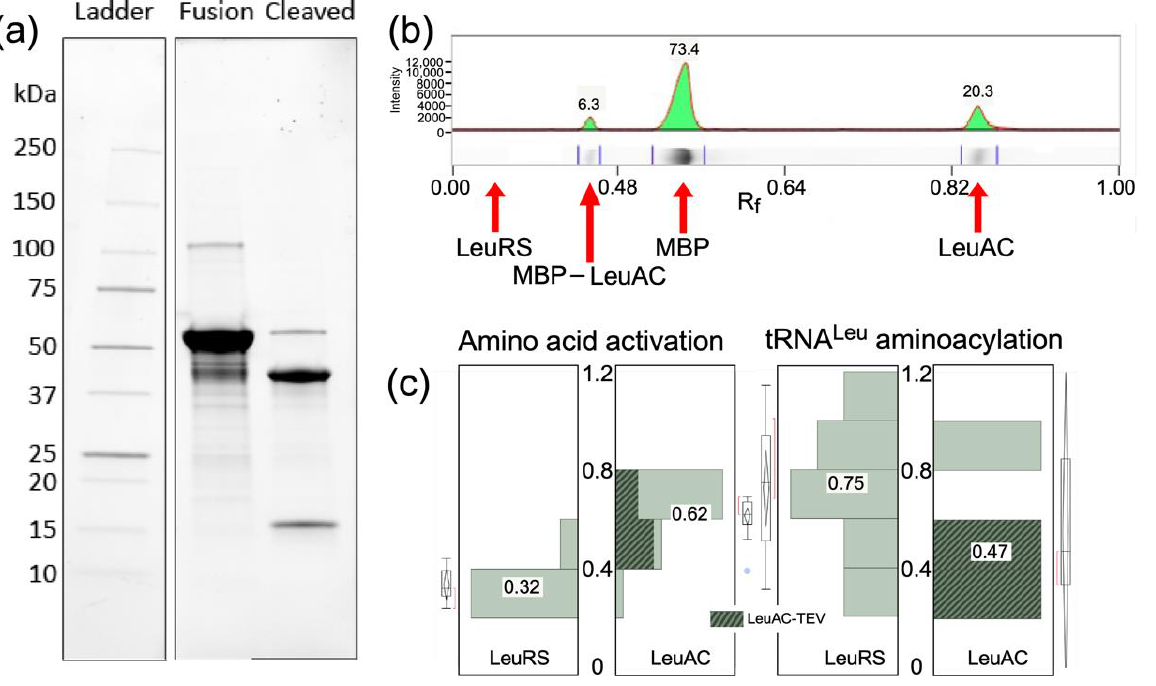
Figure 1. Purity of LeuAC urzyme. ( a ) PROTEAN ® TGX PAGE gel of purified LeuAC-MBP fusion protein and its TEV-cleaved products. Visualization is proportional to the tryptophan content of each band, as noted in the text. ( b ) Densitometric scan of the gel in ( a ). Integrated peak percentages are indicated for full-length LeuRS, LeuAC_MBP fusion, MBP, and LeuAC. ( c ) Distributions of amplitude parameters, A, estimated by fitting [ 32 P] ATP consumption and tRNA Leu aminoacylation time courses for LeuRS and TEV-cleaved LeuAC to Equation (1). Acylation experiments include the subset of experiments from Supplementary Table S2 that most closely approximate single turnover conditions (5 > [substrate]/[enzyme] > 0.5). Median A values given as fractions against a white background are aligned with horizontal lines in the box plots. Median values for activation differ by 11.5 times the standard error of the mean for LeuRS ( n = 13). For acylation the difference between median values for full length LeuRS and LeuAC, 0.27, is 3.7 times the standard error of the mean for LeuRS ( n = 7). The difference for activation is both larger and inverted because LeuAC converts near stoichiometric amounts of ATP into ADP, in addition to AMP, as discussed in Sections 2.3.2 and 3.3.